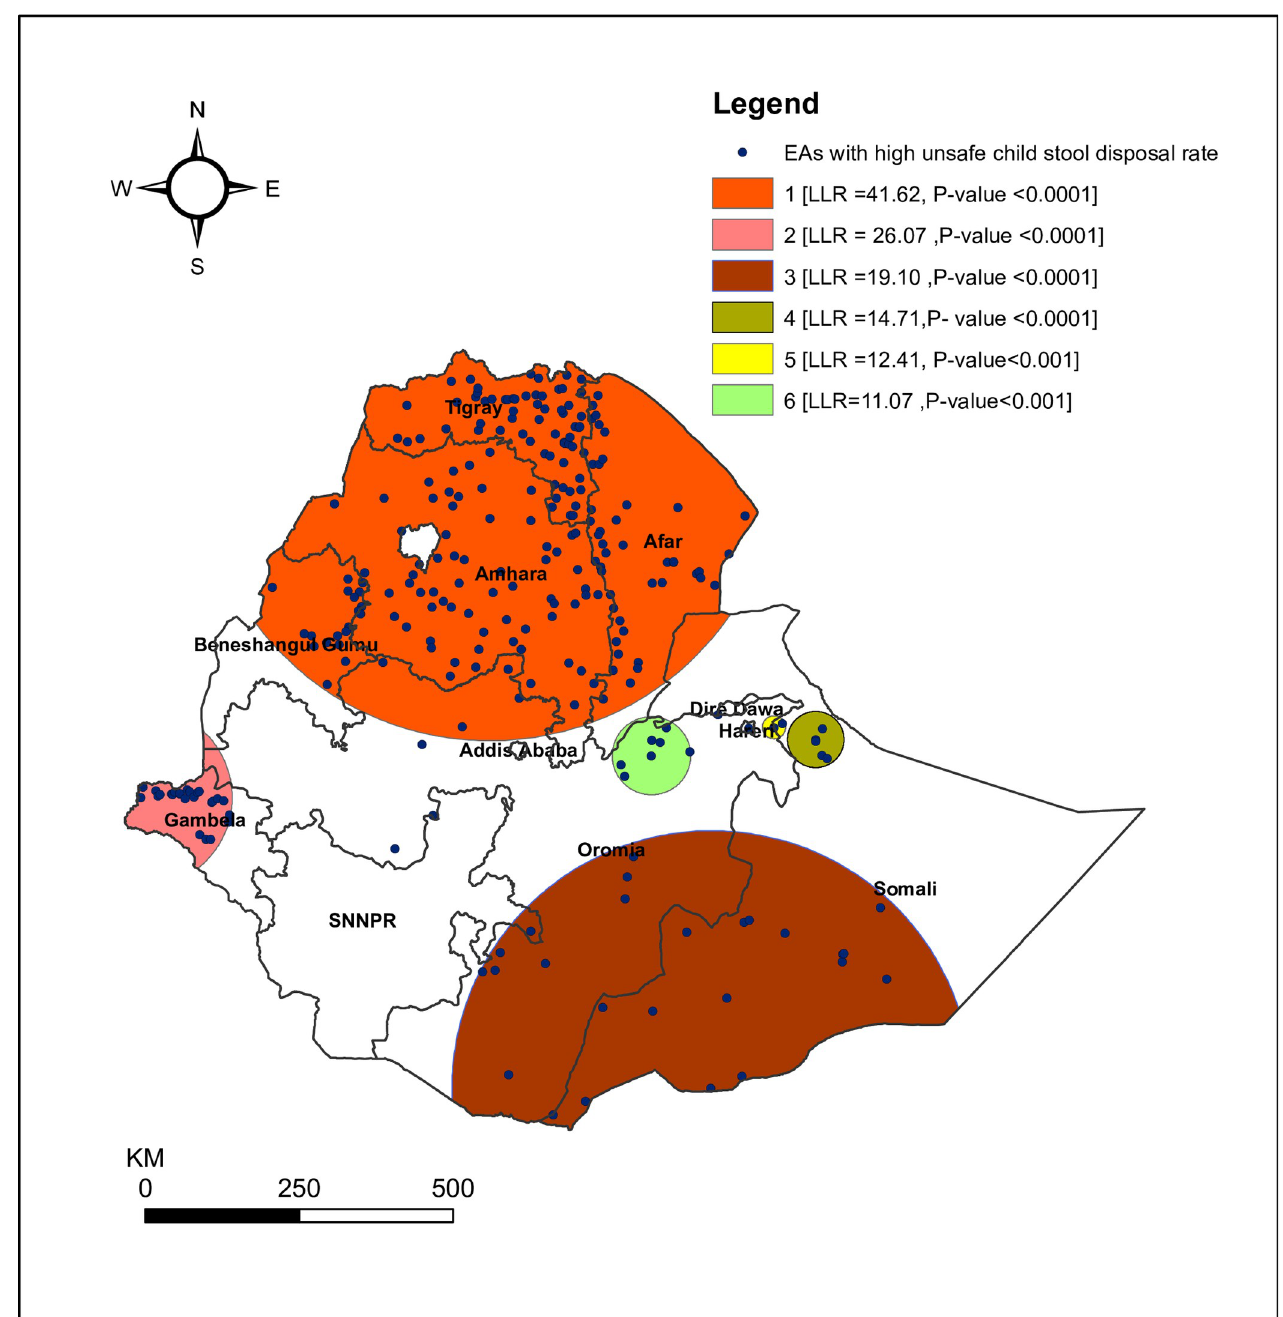
Fig 3. The spatial clustering of areas with high unsafe child stool disposal in Ethiopia, EDHS 2016. Source: Shapefile of the map was freely available from https://africaopendata.org/dataset/ethiopia-shapefiles.